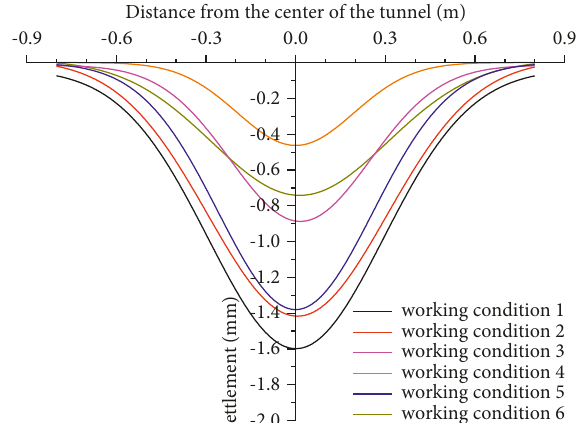
Figure 15: Variation of surface subsidence at different measure